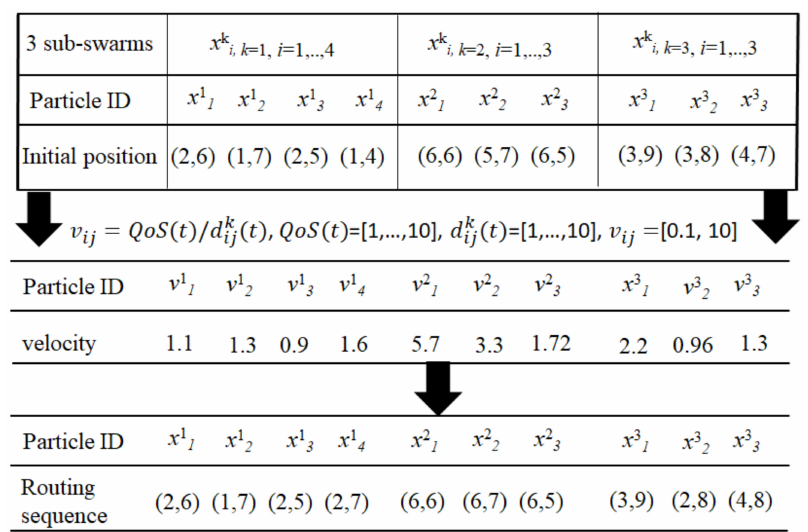
Figure 6. An example of the state update of the PSO particles in k subswarm movement.